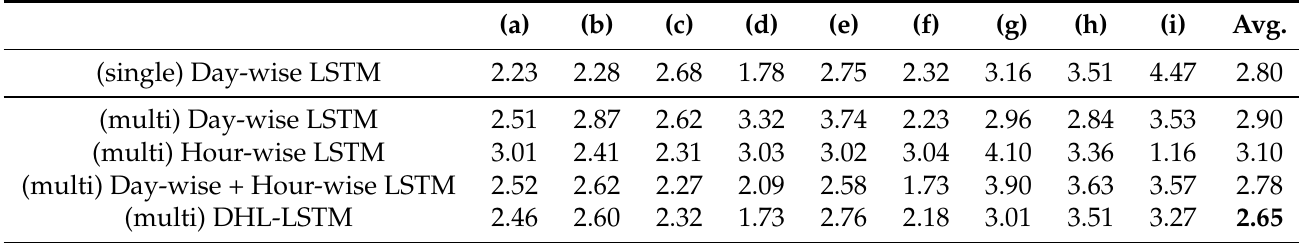
Table 5. RMSEs of temperature prediction for nine different scenes, based on the single-task day-wise model, the multi-task day-wise model, the multi-task hour-wise model, the multi-task day-wise plus hour-wise model, and the DHL-LSTM model.